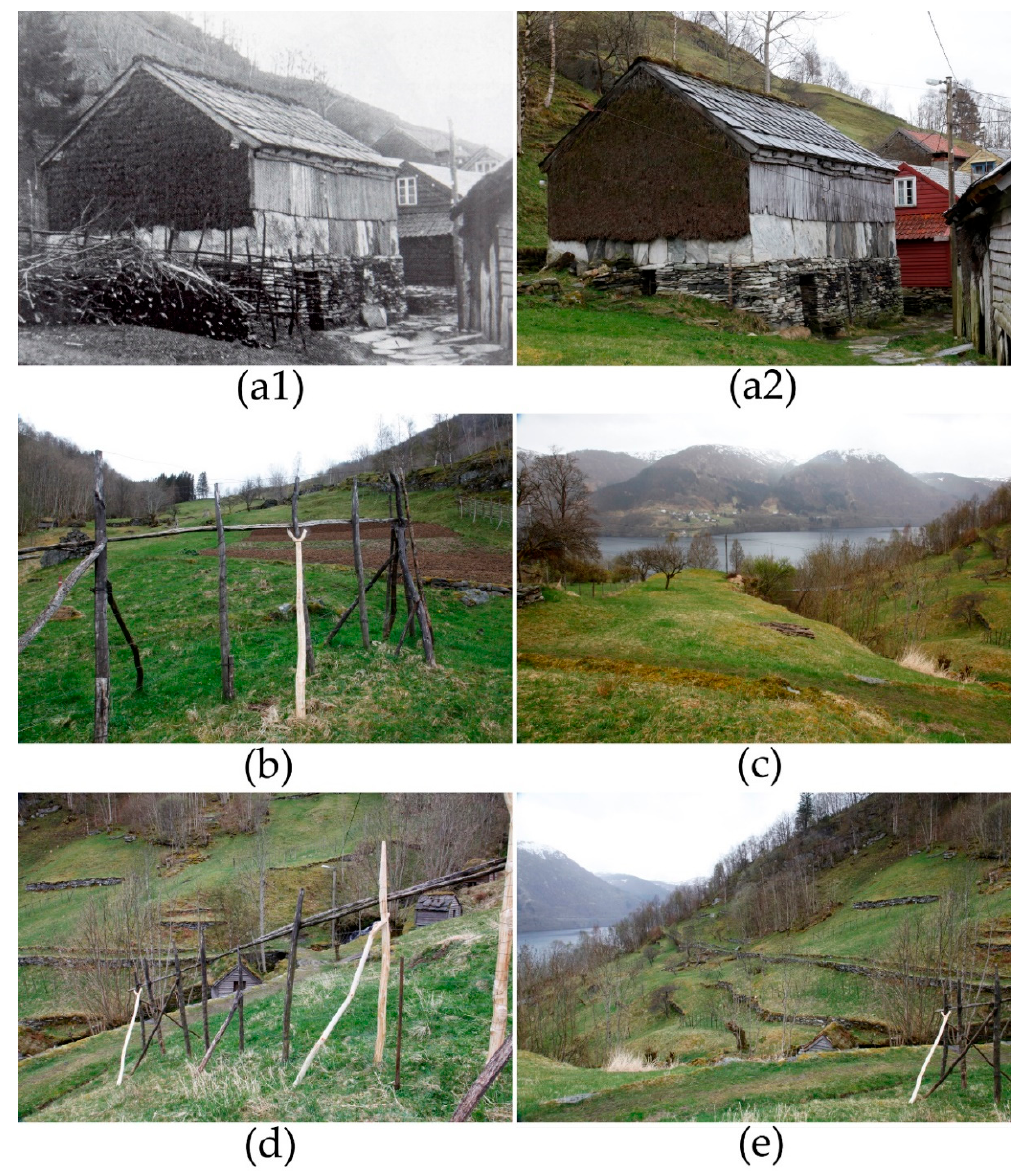
Figure 6. Photographs taken from a supplementary (qualitative) photo-point into an originally chosen direction, in this case east, in 1950 ( a1 ) and 2015 ( a2 ), and additionally towards north ( b ), south ( c ), and west ( d ) and into a freely chosen direction, west-southwest ( e ). Photos: Sverre Mo (1950), O.P./NIBIO.